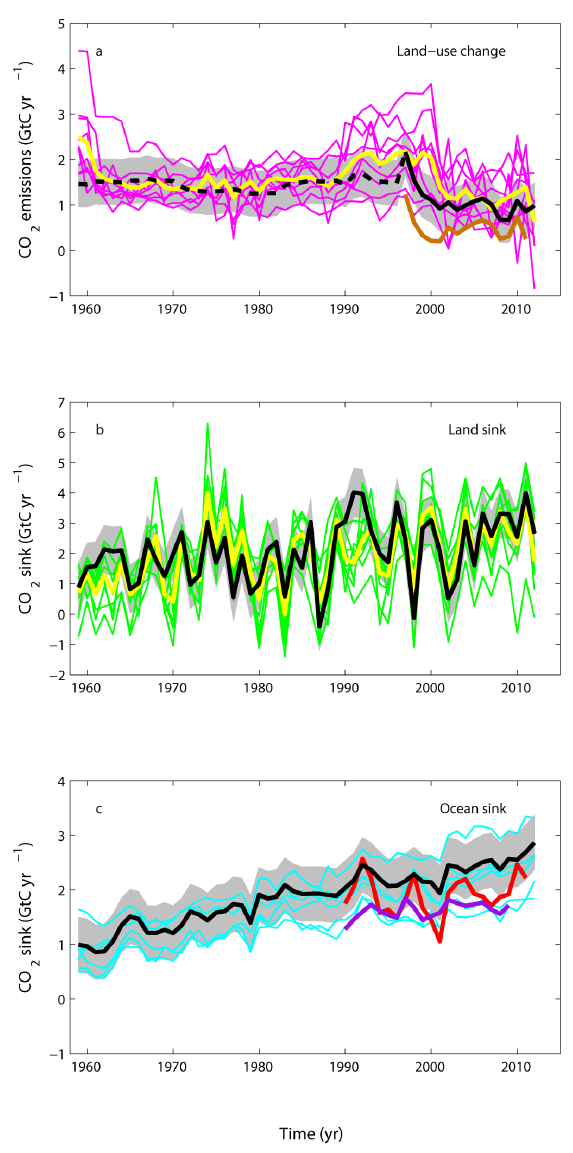
Figure 5. Comparison between the CO 2 budget values estimated here (black line), and other methods and models (Table 6; coloured lines) for (a) CO 2 emissions from land-use change showing indi- vidual DGVM model results (magenta) and the multi model mean (yellow line), and fire-based results (orange), LUC data prior to 1997 (dashed black line) highlights the start of satellite data from that year (b) land CO 2 sink ( S LAND ) showing individual DGVM model results (green) and multi model mean (yellow line), and (c) ocean CO 2 sink ( S OCEAN ) showing individual models before nor- malisation (blue lines), and the two data-based products (red line for Rödenbeck et al. (2014) and purple line for Park et al., 2010). Both data-based products were corrected for the preindustrial source of CO 2 from riverine input to the ocean, which is not present in the models, by adding a sink of 0.45GtCyr − 1 (Jacobson et al., 2007), to make them comparable to SOCEAN .